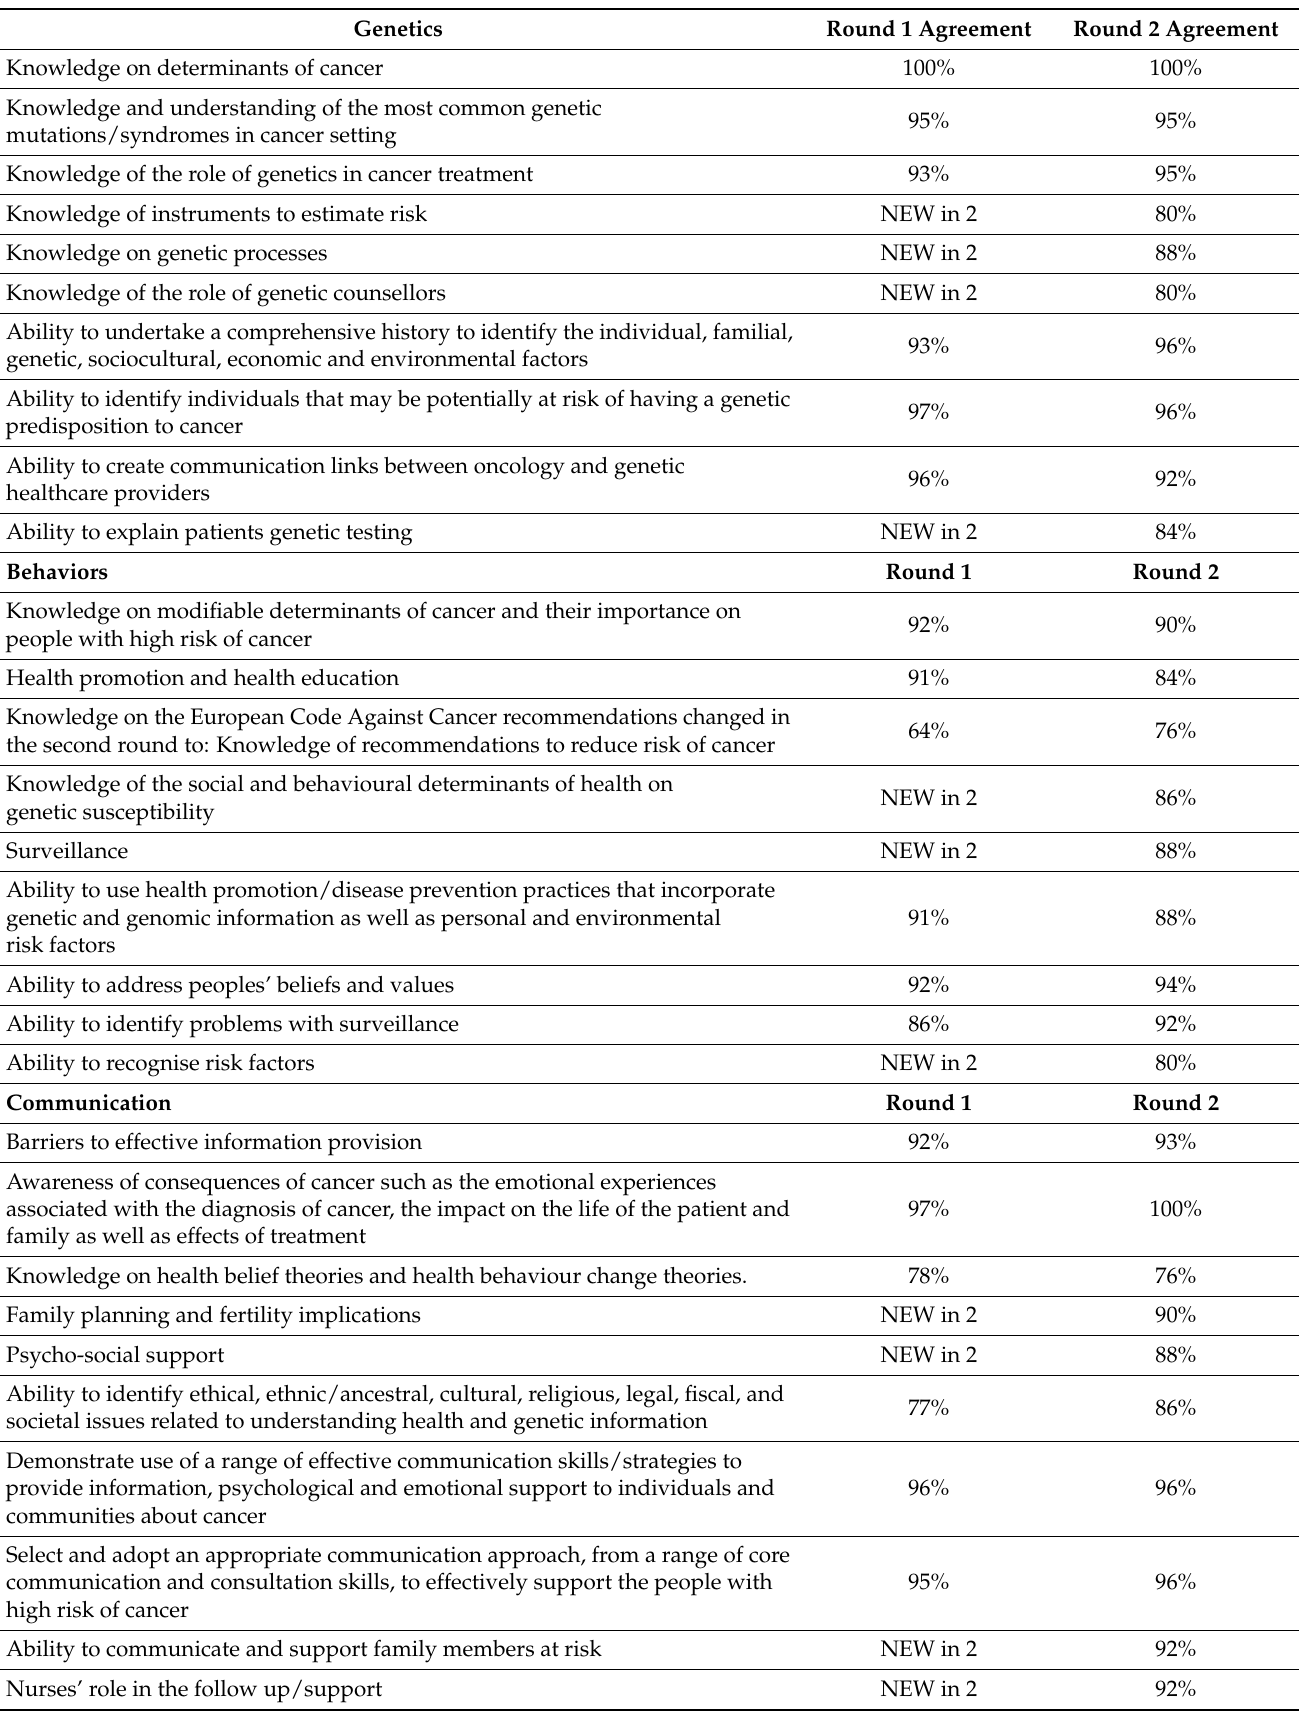
Table 1. Educational items proposed in the two Delphi rounds and % of